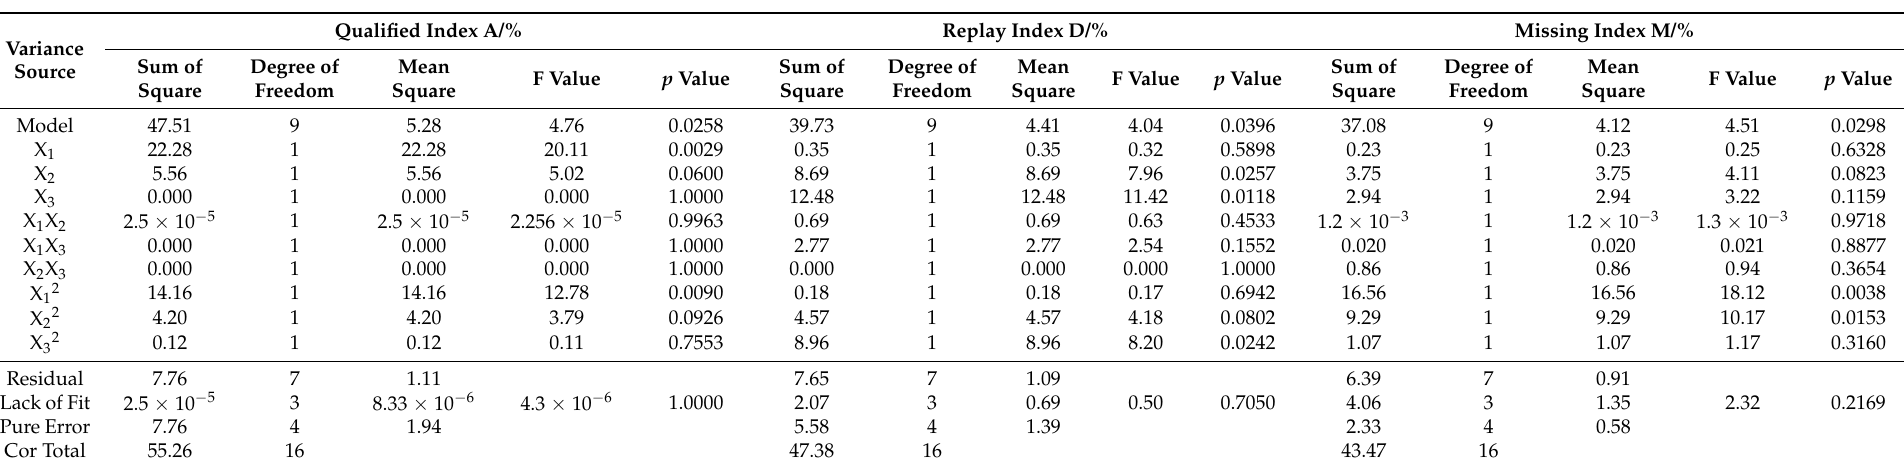
Table 6. Analysis of variance